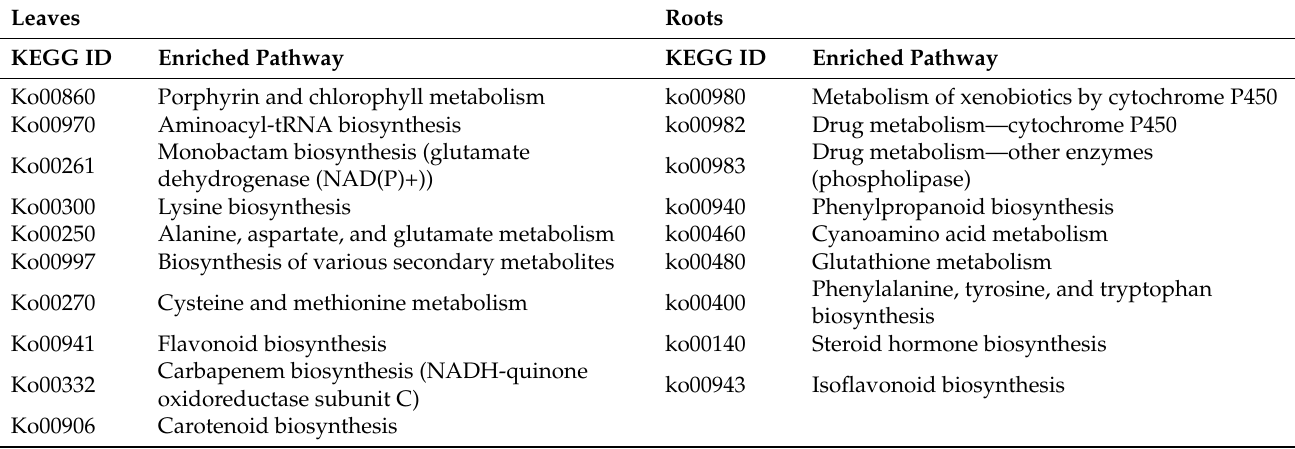
Table 1. Over-represented KEGG pathways identified in barley leaves and roots under salt